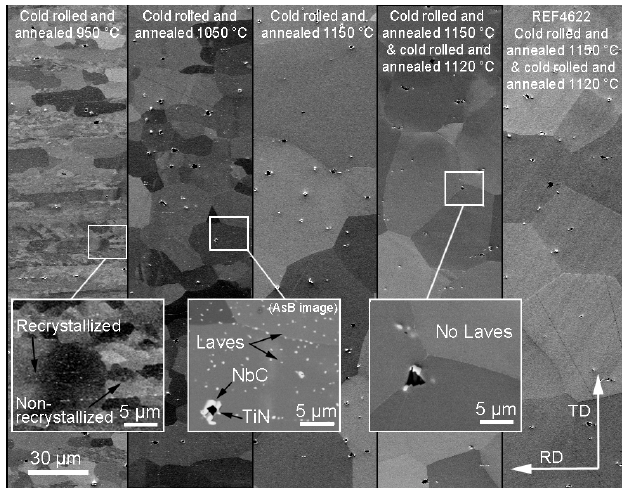
Figure 6. FESEM secondary electron and backscatter images of samples after each process phase.